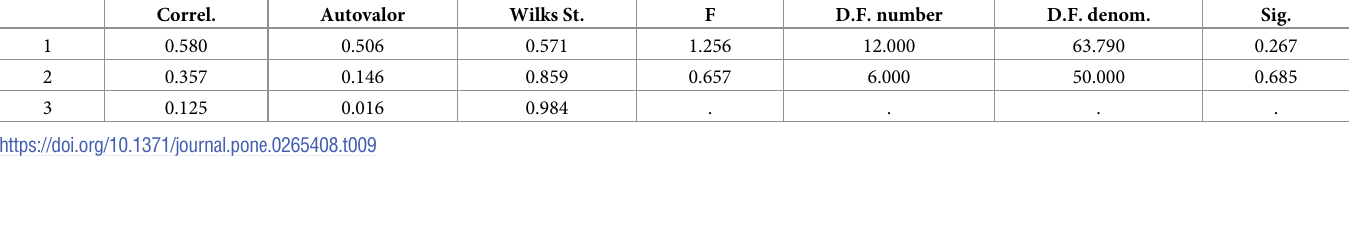
Table 9. Canonical correlations: Experimental group after the experiment. Correl.